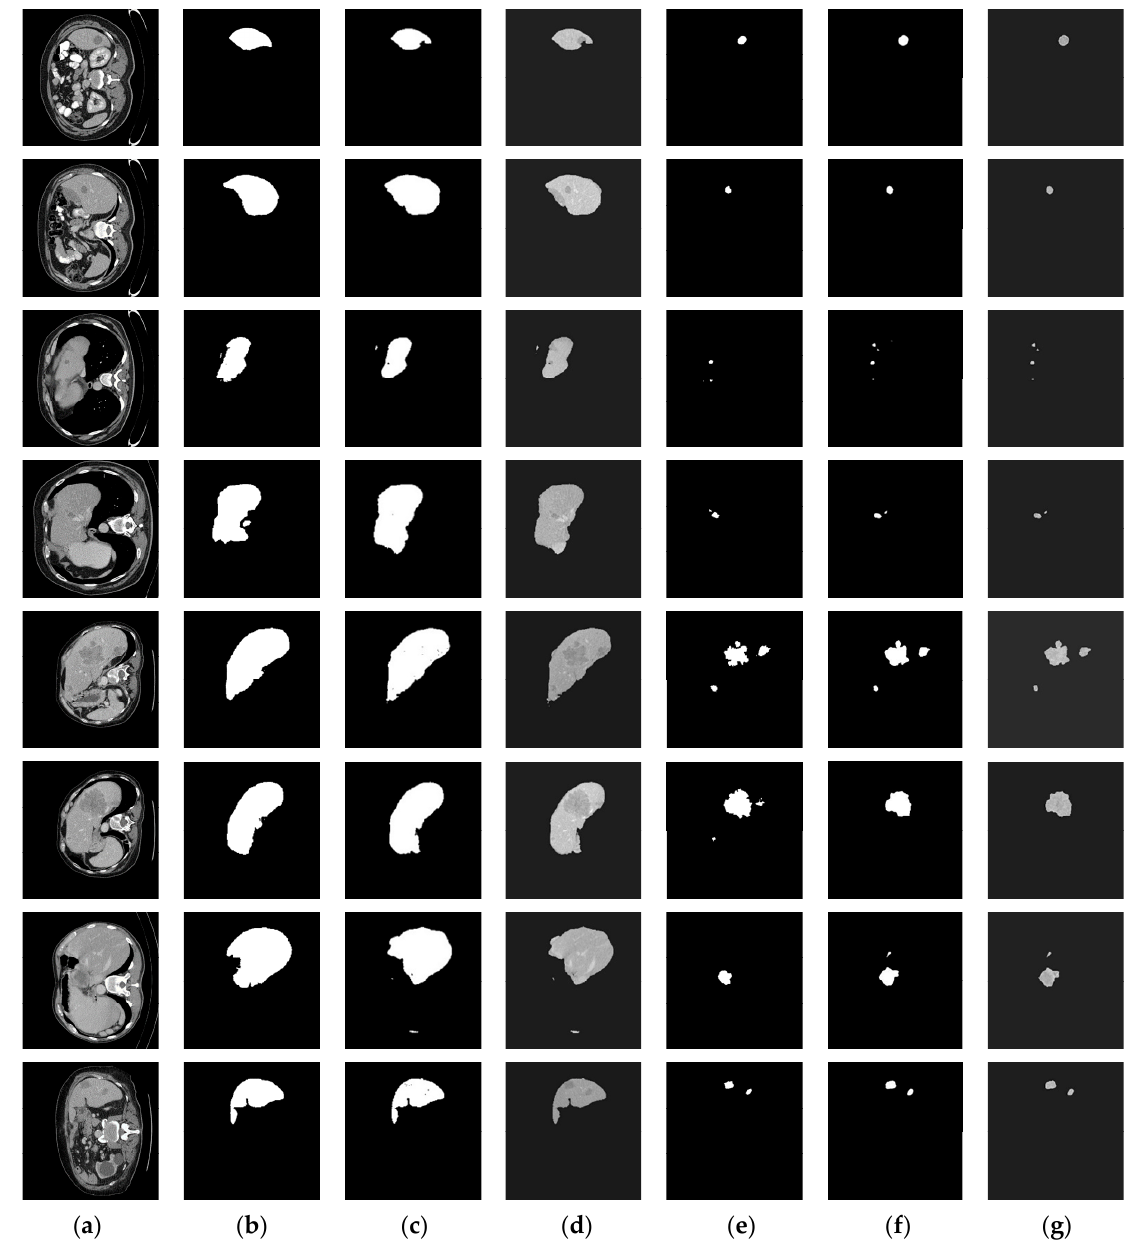
Figure 5. The segmentation results of the proposed SED. Each raw CT presents the result of each test image: ( a ) Raw CT image, ( b ) Liver ground truth, ( c ) SED-1 predicted liver mask, ( d ) Liver image, ( e ) Tumor ground truth, ( f ) SED-2 predicted tumor mask, and ( g ) Final tumor segmentation result.